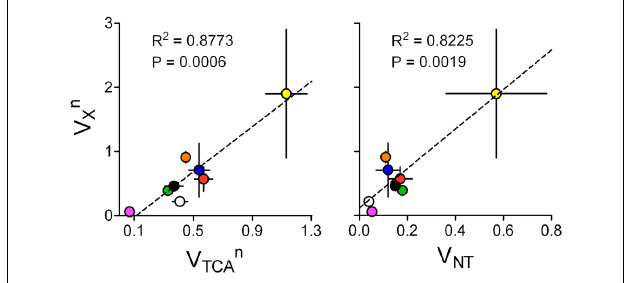
FIGURE 9 | V n and V n are on the same order of magnitude and TCA X is also linearly related to glutamatergic or related (left) . Accordingly, V n X GABAergic V NT (right). Data was collected from the same experiments as in Figure 8 , which determined both fluxes in an independent manner: rat brain under pentobarbital-induced isoelectricity [white; Ref. (102)]; rat brain under light α -chloralose anesthesia [orange, blue, and black are from Ref. (9, 10, 35)]; rat brain under light α -chloralose anesthesia but data modeled with three metabolic compartments [pink/green are GABAergic/glutamatergic compartments in Ref. (12)]; human cortex [red; Ref. (29)]; awake rat brain [yellow; Ref. (33)]. Metabolic fluxes are shown in micromoles per gram per minute with associated SD. P -value for the slope and R 2 are shown for each linear